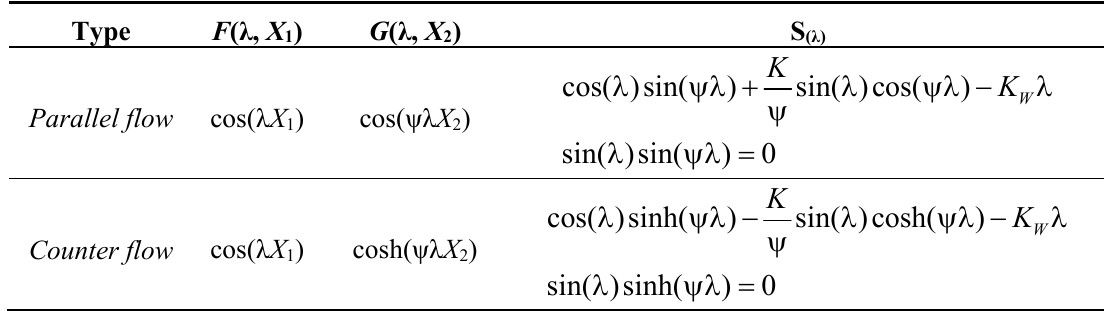
Table 1. F, G and Eigen functions for parallel flow and counter flow plate heat exchangers. Type Parallel